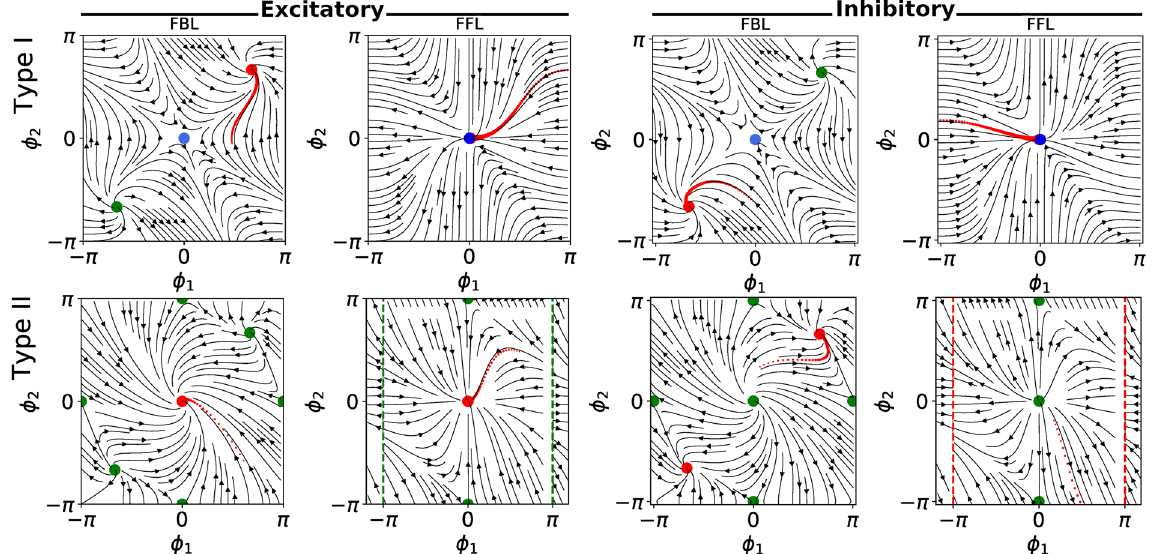
Figure 1. Phase plane portraits for reduced two-dimensional systems of type I and type II motifs. The phase plane portraits for reduced two-dimentional systems of (top row) type I and (bottom row) type II phase oscillators situated in a FBL, and FFL motifs. The plots on the left-hand side (right-hand side) of the figure correspond to the excitatory (inhibitory) oscillators. The stable and unstable (or saddle) fixed points have been distinguished by red and green colours, respectively. The Jacobian matrices of the fixed points coloured in blue have two zero